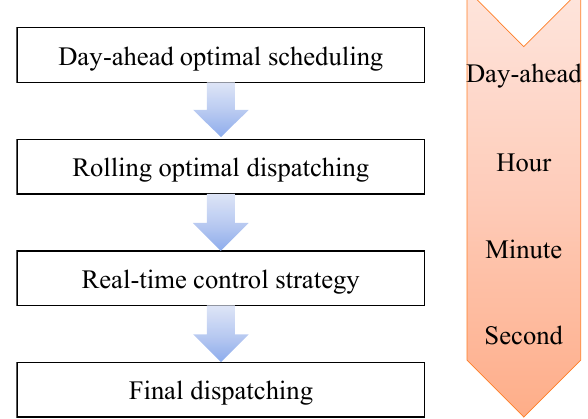
Figure 2. Multi-time period optimal dispatching scheme.